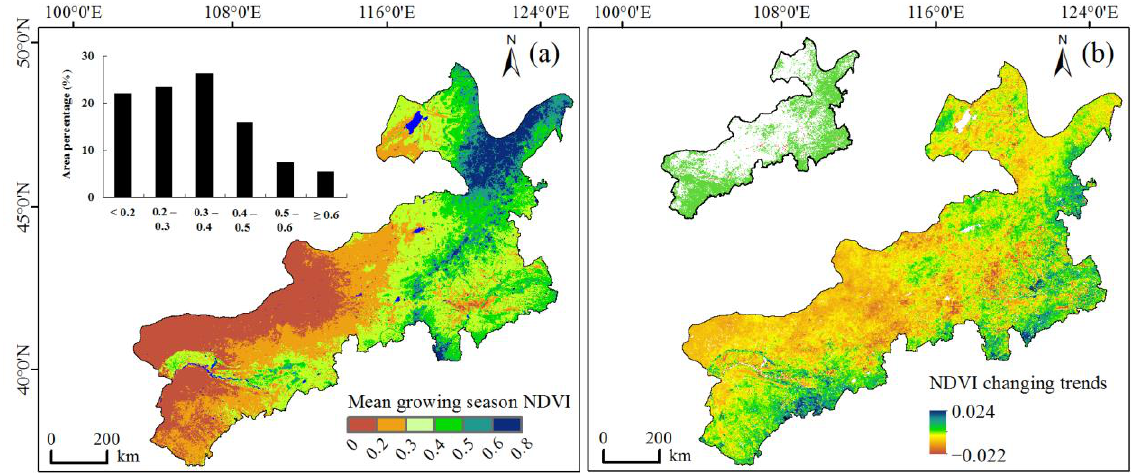
Figure 7. The ( a ) spatial distribution of the growing season average NDVI and ( b ) the slope of the change in the NDVI from 2000 – 2018. The inset graph in ( a ) is a statistical histogram; the inset map in ( b ) shows the significant decreases (red) and increases (green) in the NDVI at the 95% confidence level.